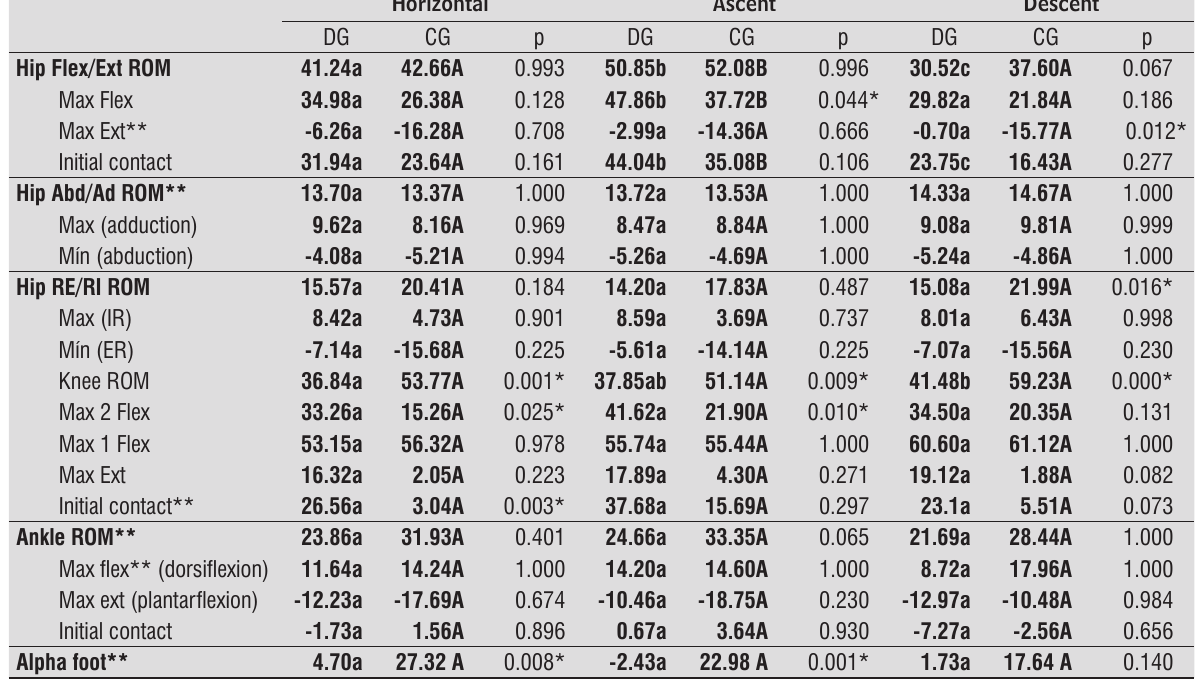
Table 2 - Gait angular variables of the lower limbs and trunk (mean) of children with spastic diplegic and control group dur- ing the horizontal, ascent and descent surface